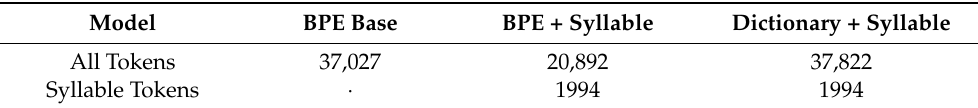
Table 1. Number of tokens by generation